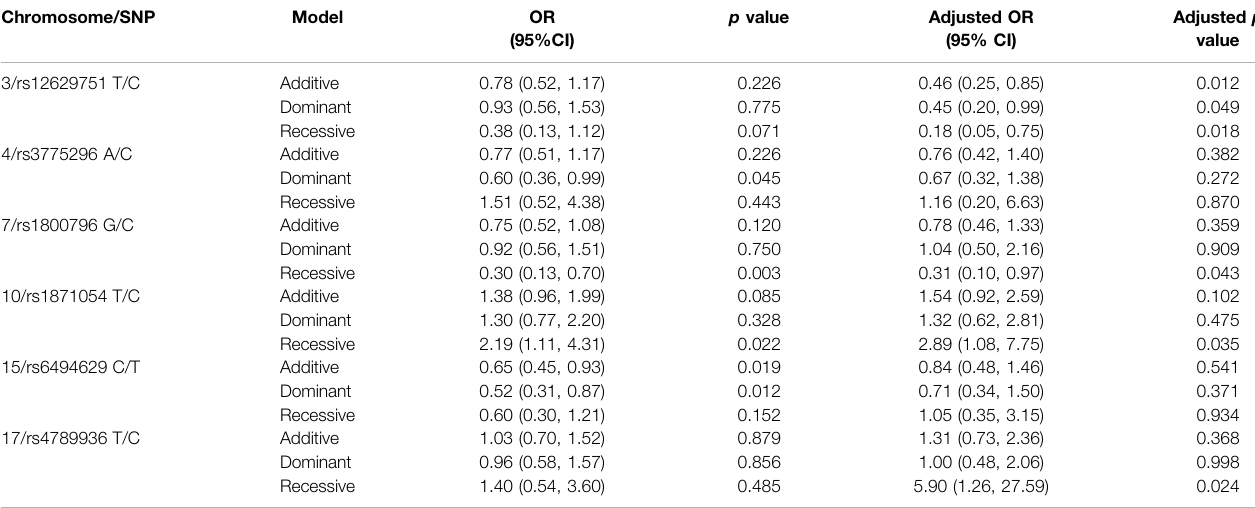
TABLE 4 | Candidate SNP loci with KBD identi fi ed by association analysis.